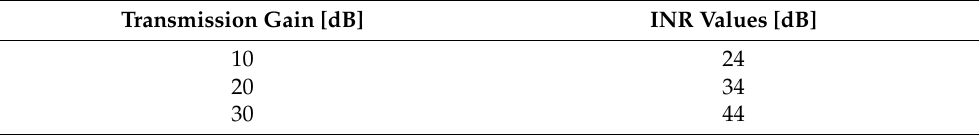
Table 3. Considered transmission gains and the corresponding measured INR values.